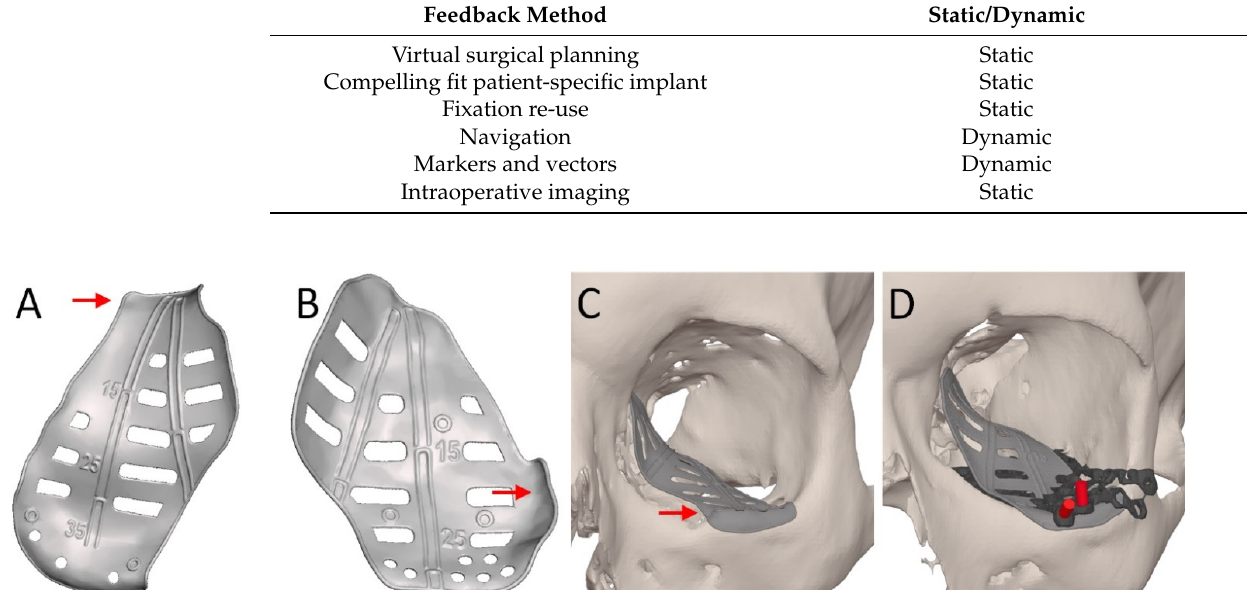
Figure 7. Illustration of the different feedback methods.). Markers and vectors are visualized in ( A ) and ( B ). Compelling fit of the patient-specific implant design is indicated with red arrows ( A – C ) Segmentation of screw holes of the previous reconstruction are illustrated in red ( D ) and the previous implant in dark grey.